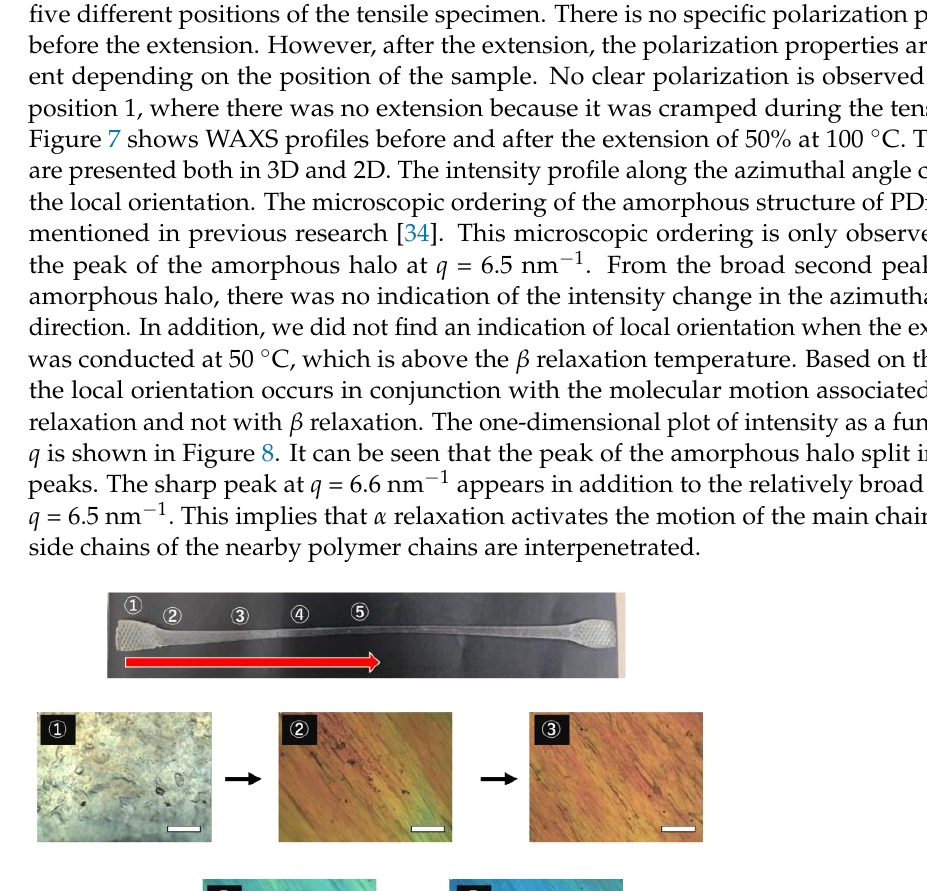
Figure 5. WAXS profiles of P(DEF -co- EA) with different fumarate fractions. The intensity is normal- ized at the peak position at q = 15 nm −1 .